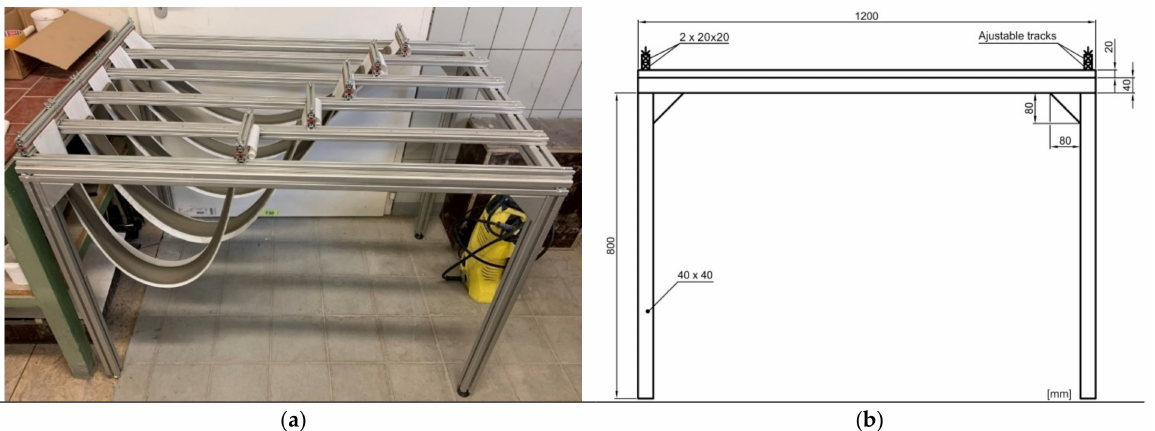
Figure 6. ( a ) Example of the formed specimens in the longitudinal direction; ( b ) drawing of the experimental setup for reshaping in the longitudinal